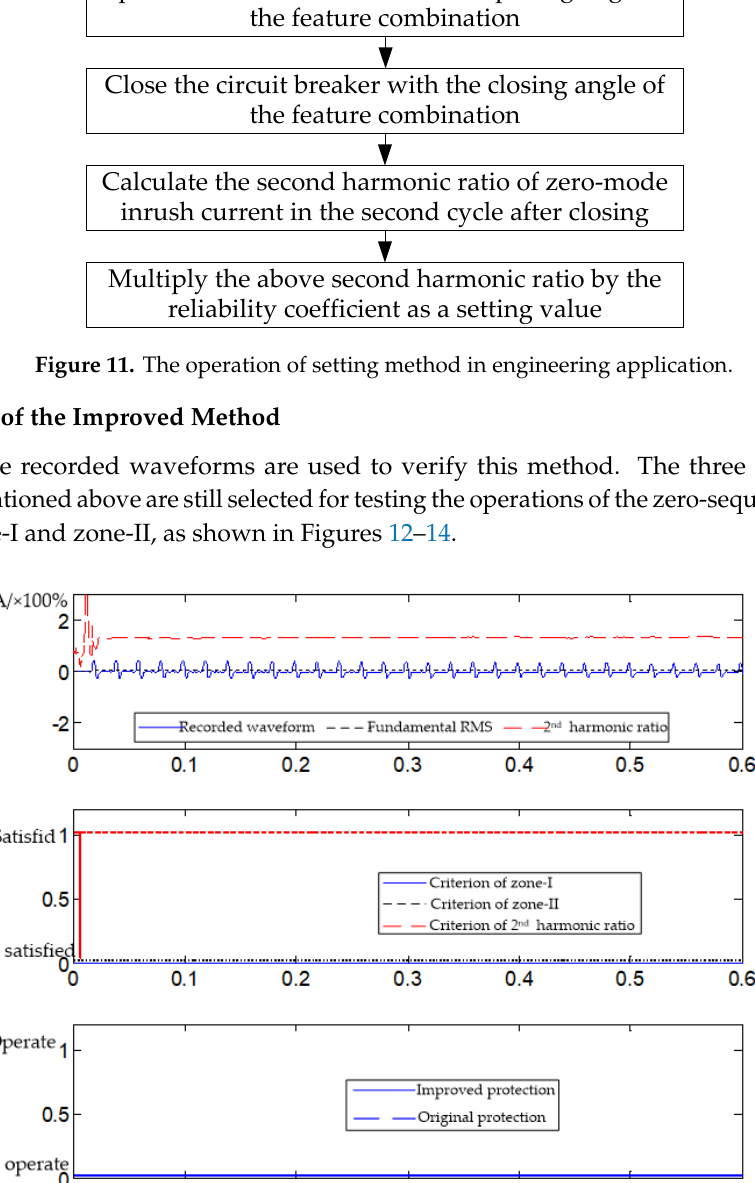
Figure 12. Protection behavior of waveform Number One.